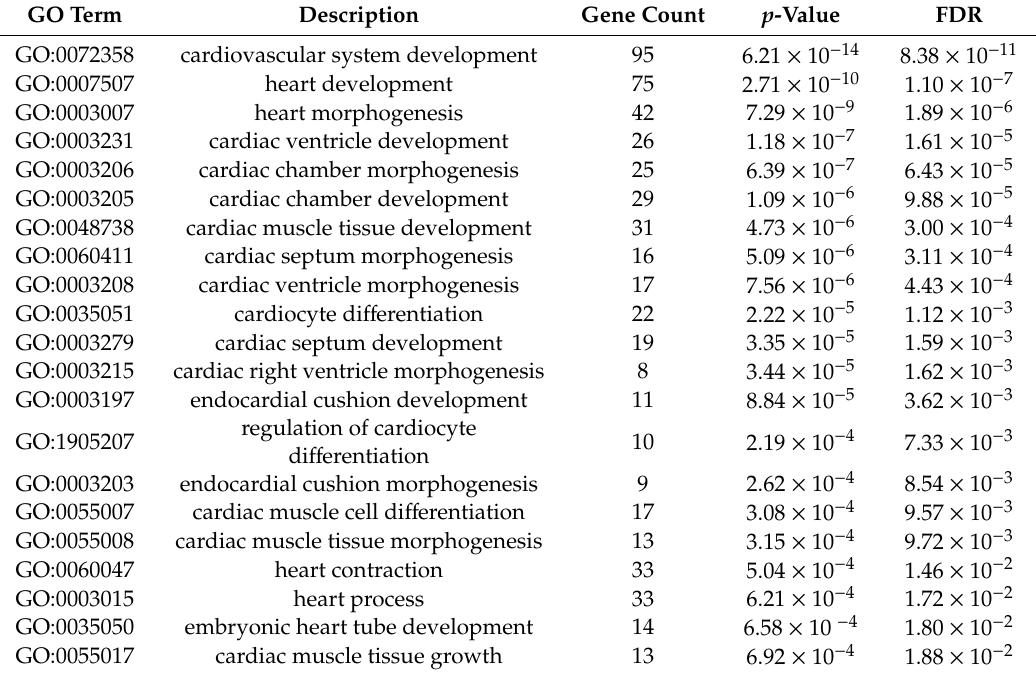
Table 4. GO enrichment of long noncoding RNA (lncRNA)-annotated protein-coding genes.